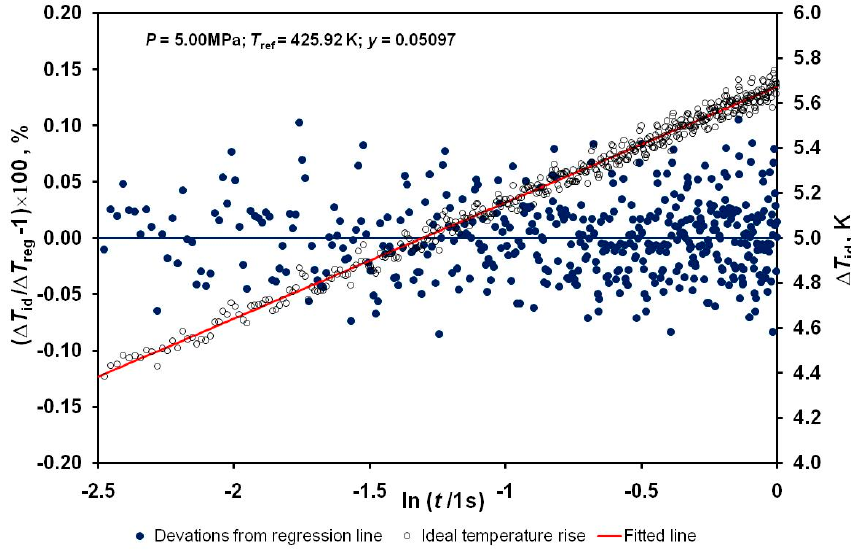
Figure 2. Deviations between the ideal temperature rises and those obtained from the linear regression line—Scattering plot, for a test with humid air, for T ref = 425.92 K, P = 5.00 MPa and y H2O = 0.05097. Adapted from [35].